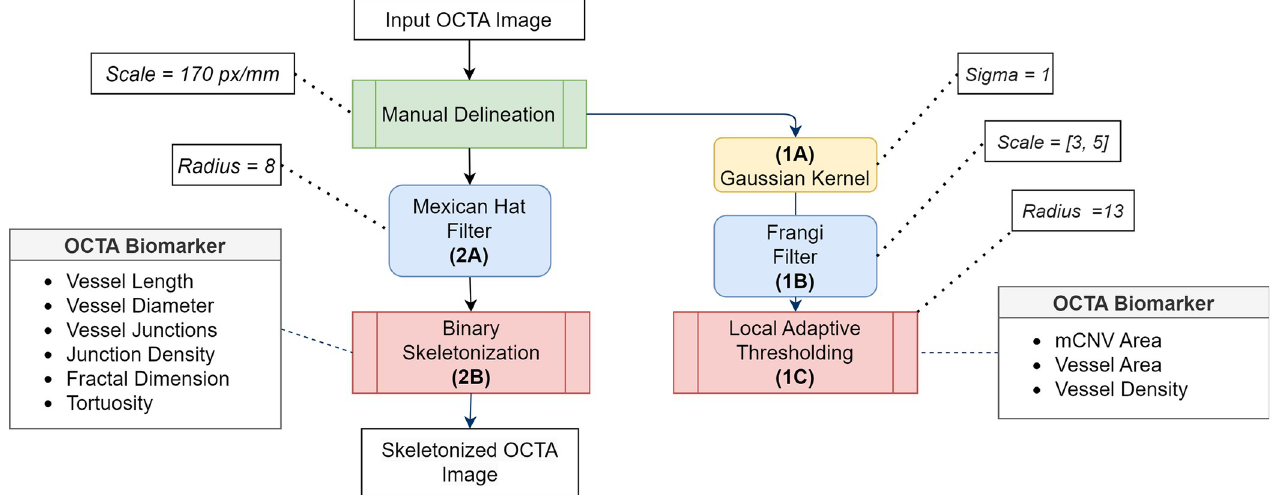
Fig 2. The OCTA image processing pipeline and its various stages. Our algorithm takes manually cropped OCTA images as input. The pipeline follows a branched structure. In Branch 1, we denoise the image (1A), apply the Frangi filter (1B), and use Median Thresholding (1C) to measure area-related biomarkers. In Branch 2, we apply the Mexican Hat filter (2A) and Binary Skeletonization (2B) to measure vascular biomarkers like junctions, diameter, fractal dimension, and tortuosity.